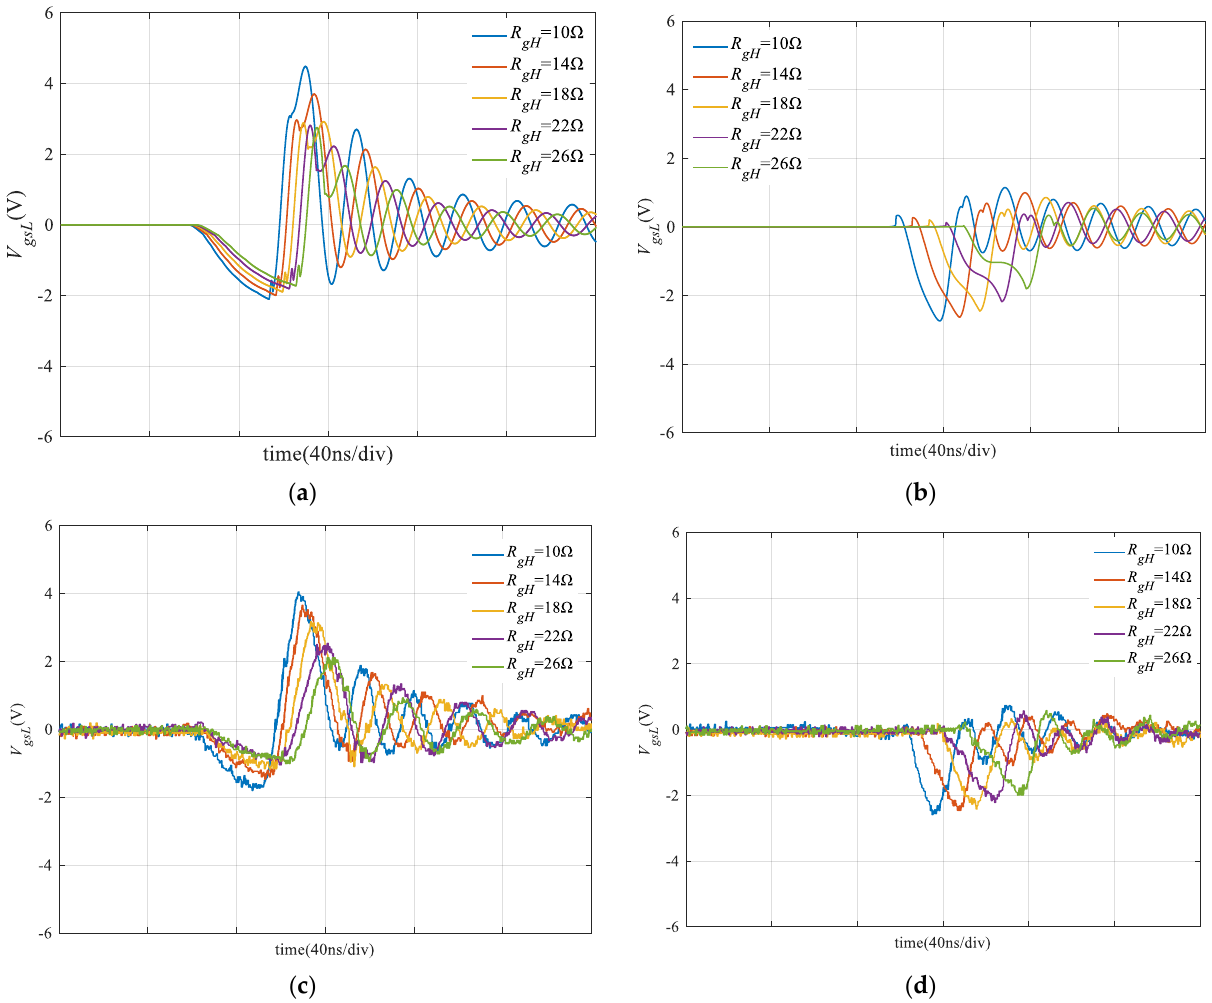
Figure 21. Comparison of simulation and experimental waveforms of crosstalk with different R gH . ( a ) and ( b ): simulation. ( c ) and ( d ): experiment. Left: turn-on. Right: turn-off.